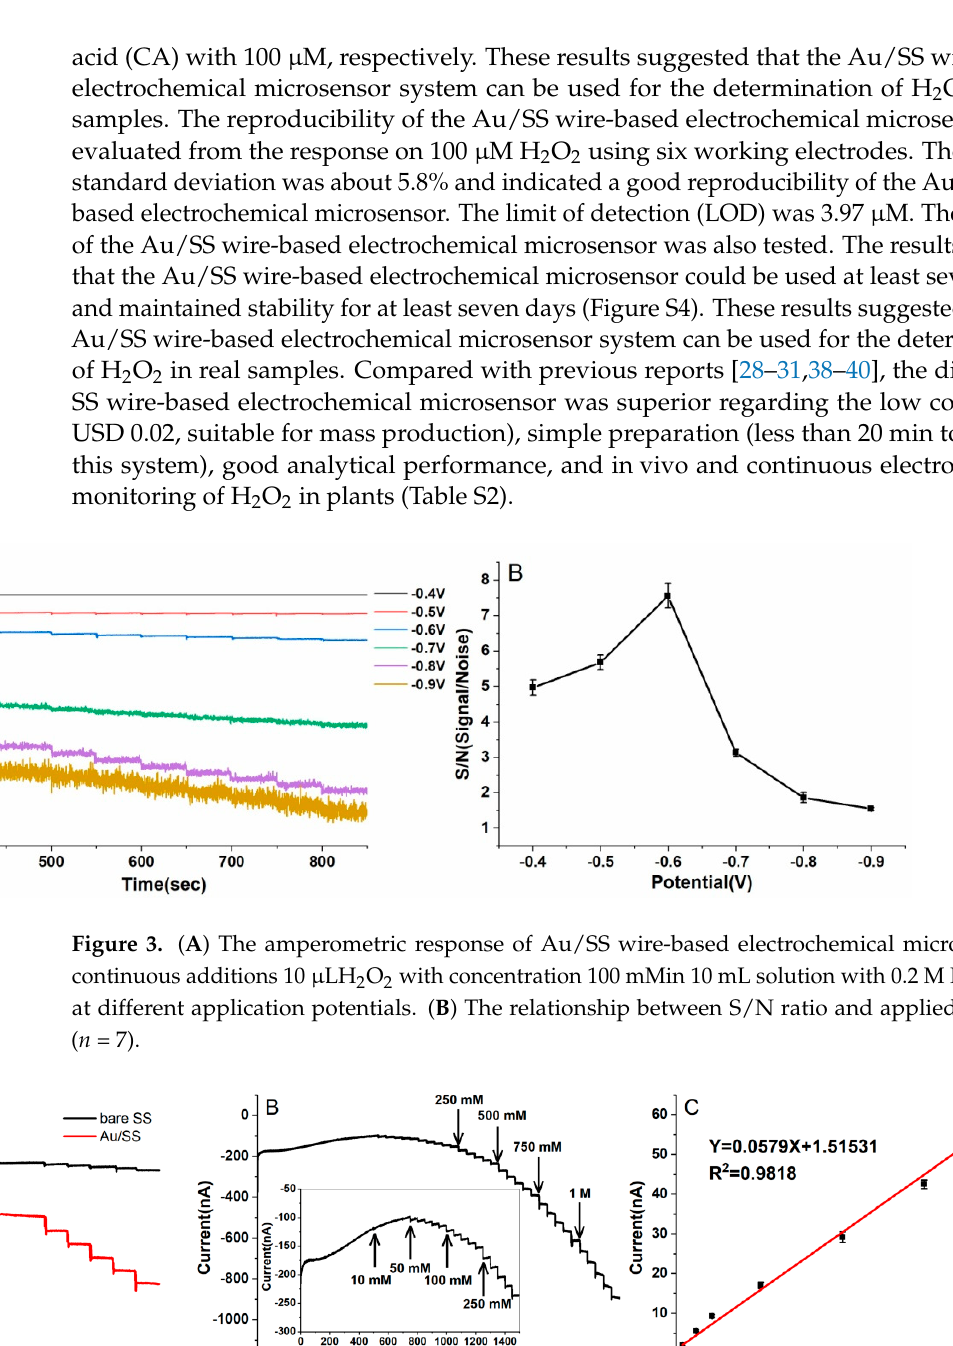
6 of 12 Figure 2. ( A ) CV curves of bare SS, and Au/SS wire-based electrochemical microsensor in the pres- ence of 100 µM H 2 O 2 in 0.2M PBS with pH 7 solution at the scanning rate of 100 mV·s − 1 . ( B ) CV curves of Au/SS wire-based electrochemical microsensor in the absence of H 2 O 2 and the presence of different concentrations of H 2 O 2 in 0.2M PBS with pH 7 solution at the scanning rate of 100 mV·s − 1 . The concentrations of H 2 O 2 were 0 µM (control, black line), 100µM (blue line), 500µM (green line),